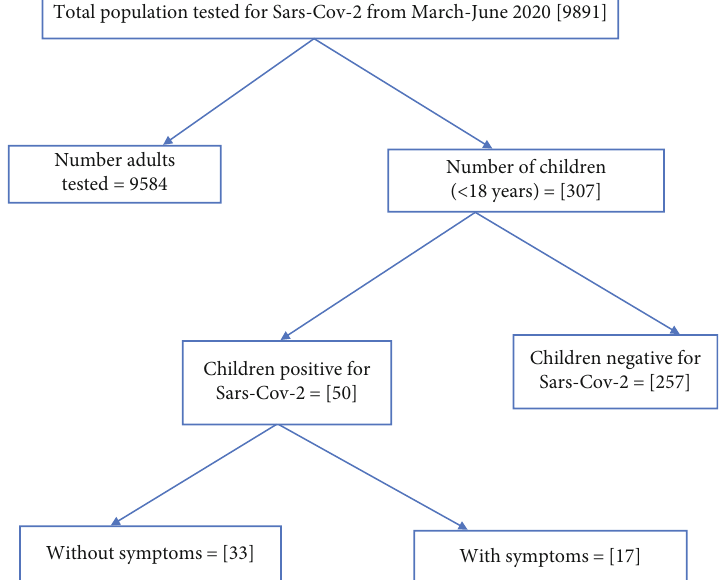
Figure 1: Flowchart of data